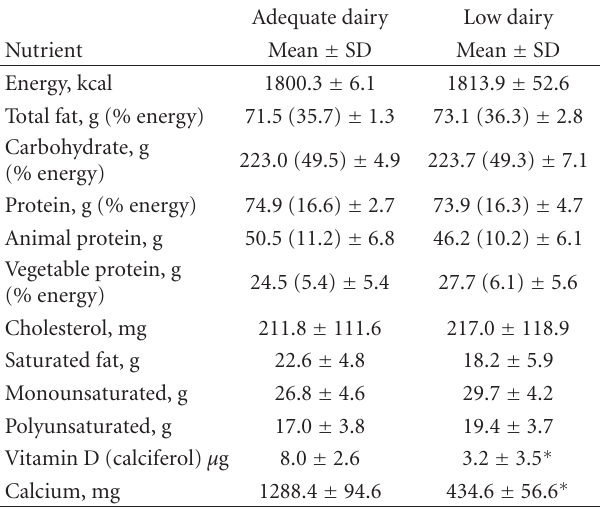
Table 1: Average nutrient distribution over a 7-day menu for ade- quate and low-dairy diets at 1800 kilocalorie